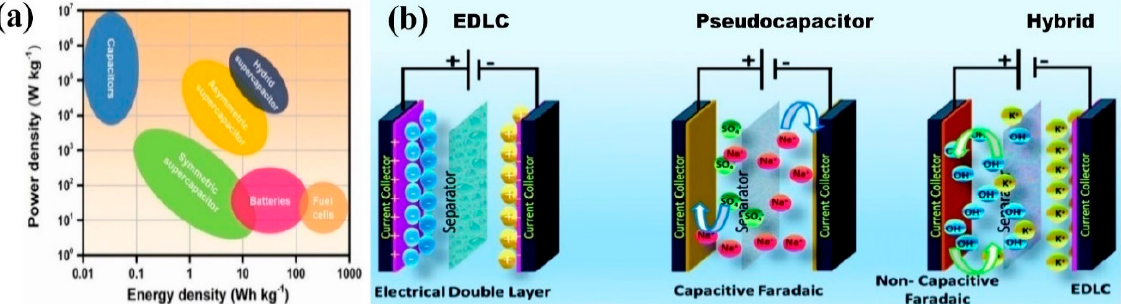
Figure 1. ( a ) Ragone plot for different electrical energy storage systems [2]. Reproduced from Ref. [2] with permission from Elsevier, 2022. ( b ) The charge storage mechanism of EDLCs, pseudocapacitors, and hybrid supercapacitors [4]. Reproduced from Ref. [4] with permission from The Royal Society of Chemistry, 2021.